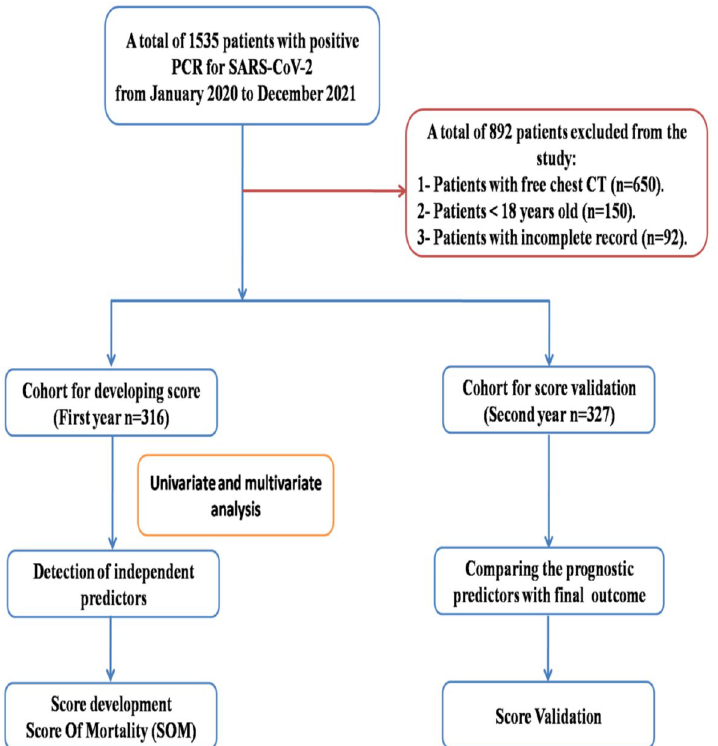
Figure 1. Flow chart for the study